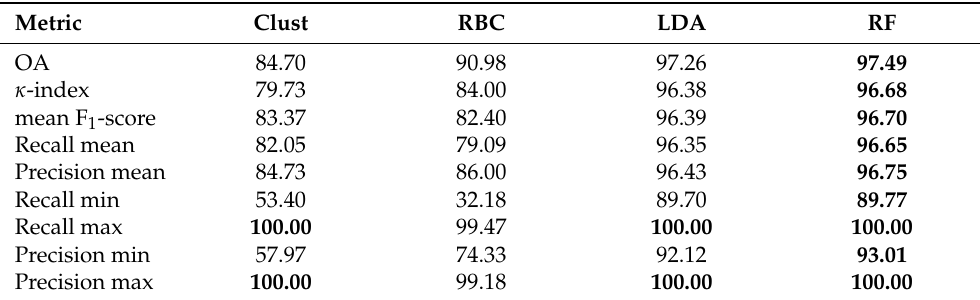
Table 3. Comparison of the results achieved with the applied classification approaches with values in % (Clust: k-means clustering with k = 8; RBC: Rule-based classification; LDA: Linear Discriminant Analysis; RF: Random Forest; OA: Overall Accuracy).